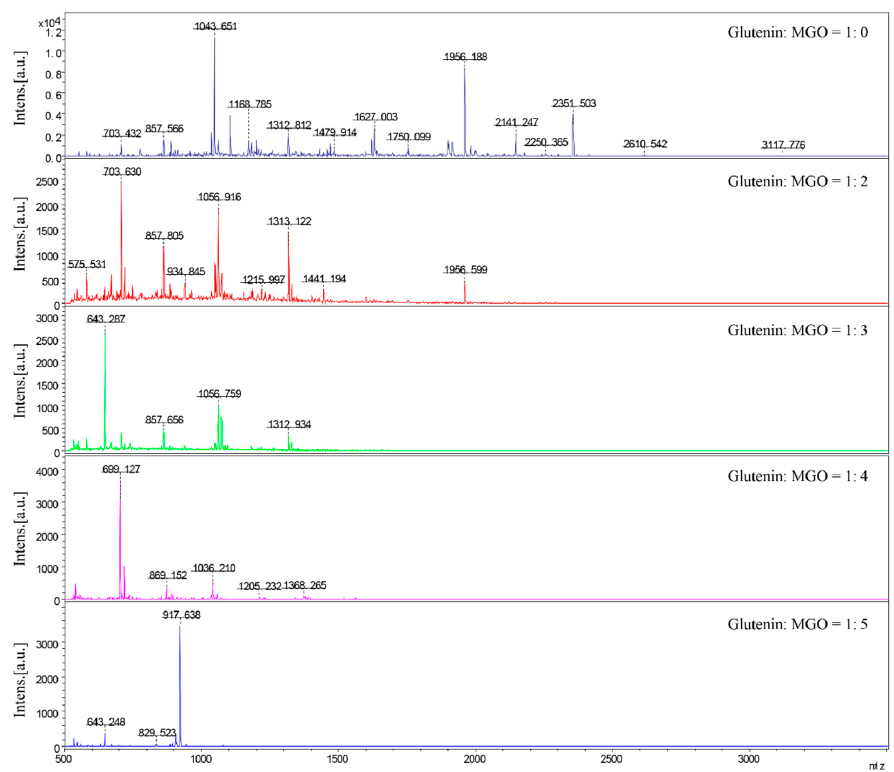
Figure 5. Peptide map analysis of glycated glutenin derived from MGO in different reactants mass ratios.